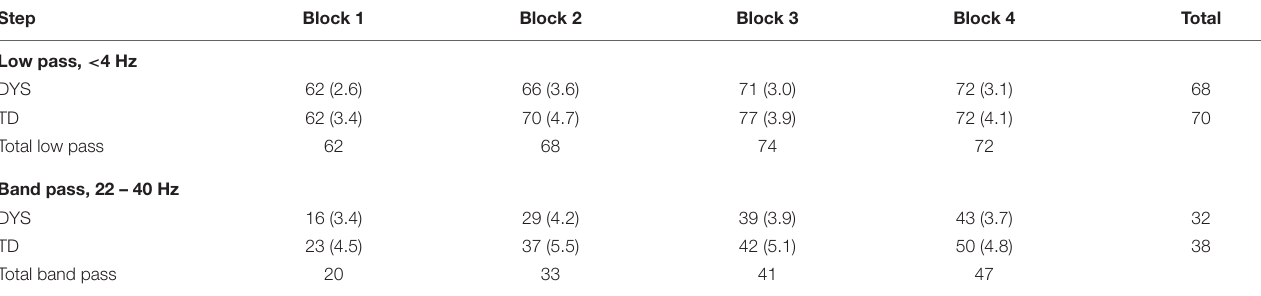
TABLE 3 | Speech recognition accuracy (% target rhymes correctly identified as trick or real) by presentation block, with standard errors in